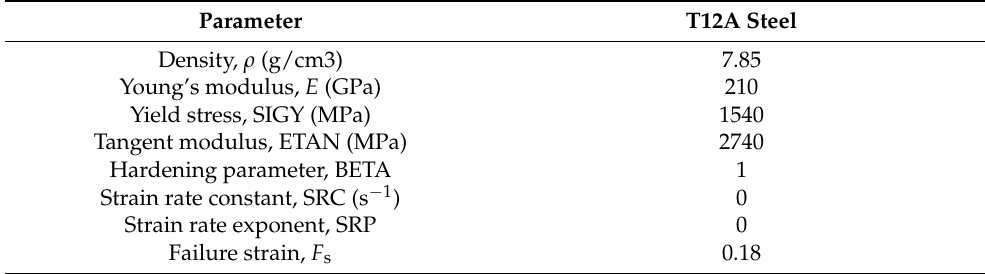
Table 2. Cowper–Symonds parameters of T12A steel, adapted from Refs. [31,32].